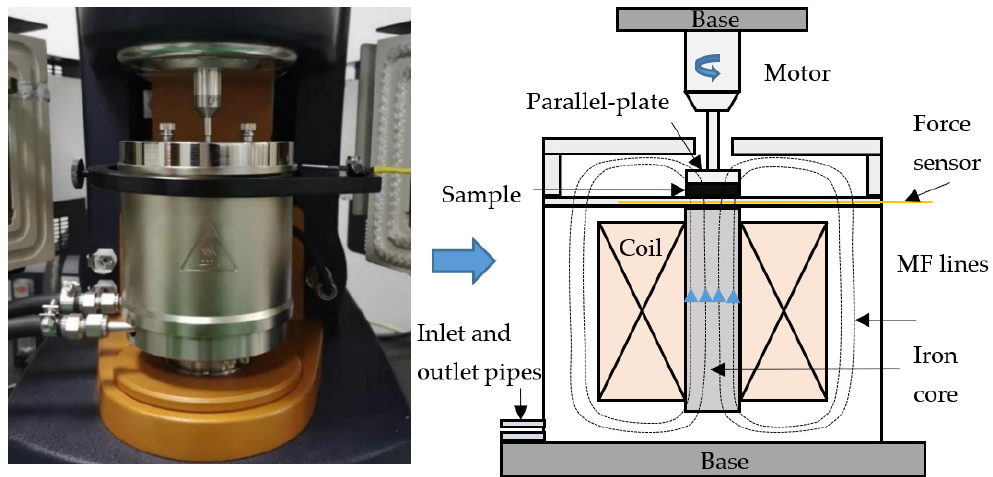
Figure 12. The photo and schematic of MR properties testing system.